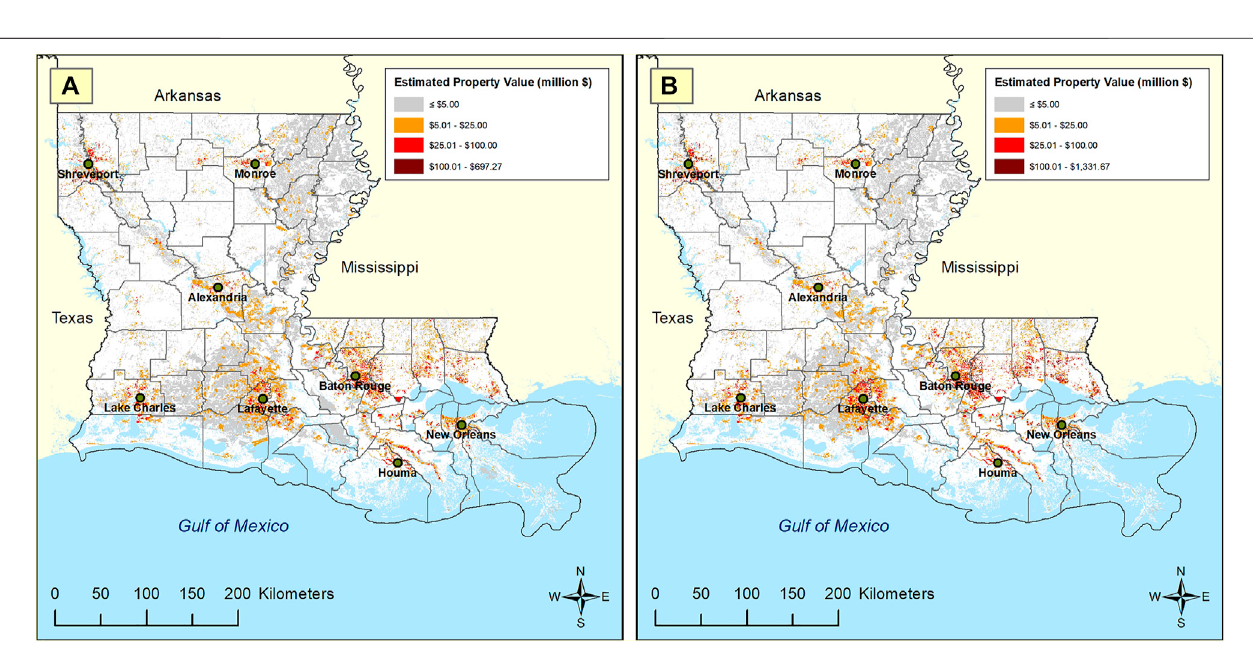
Frontiers in Environmental Science |